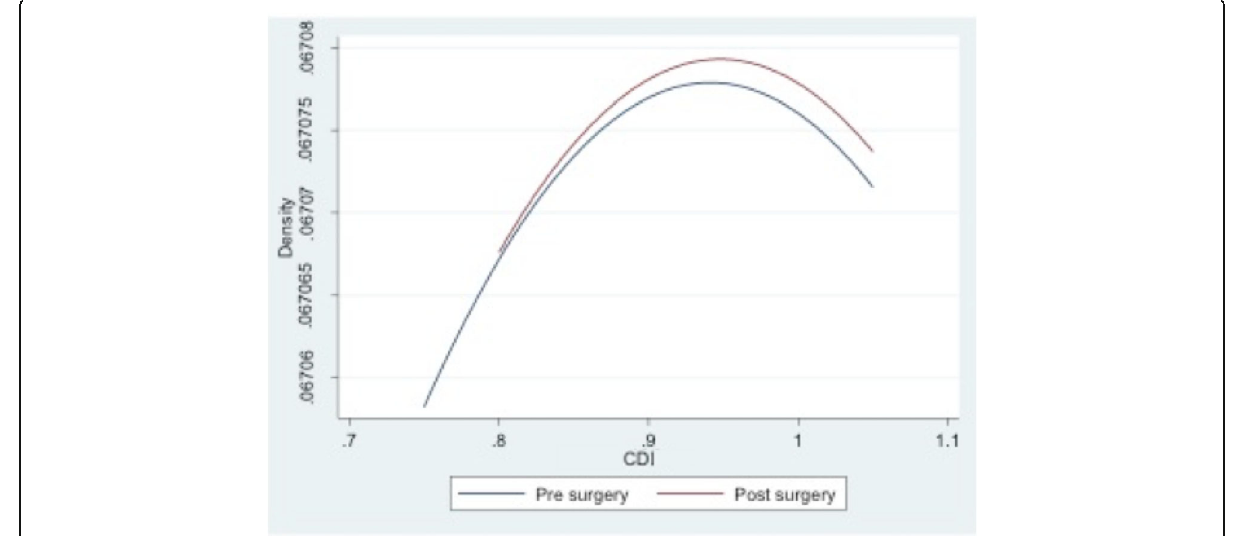
Fig. 5 Pre- and postoperative Caton-Deschamps